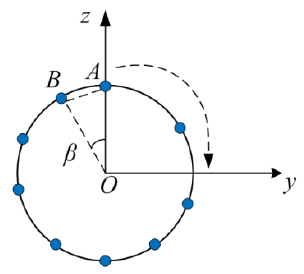
Figure 8. Graphical demonstration of the axis section acquisition point.